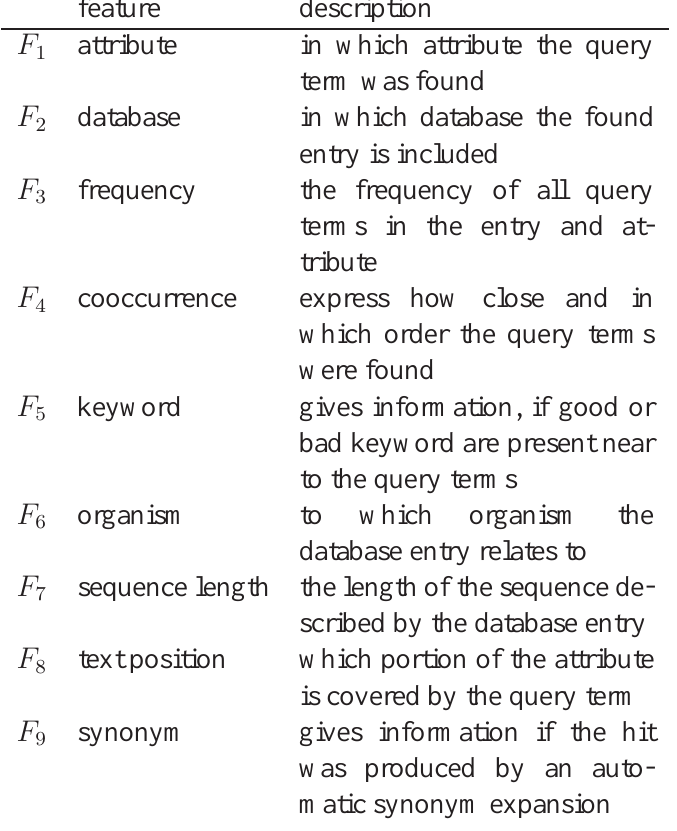
Table 1: Overview of the LAILAPS feature